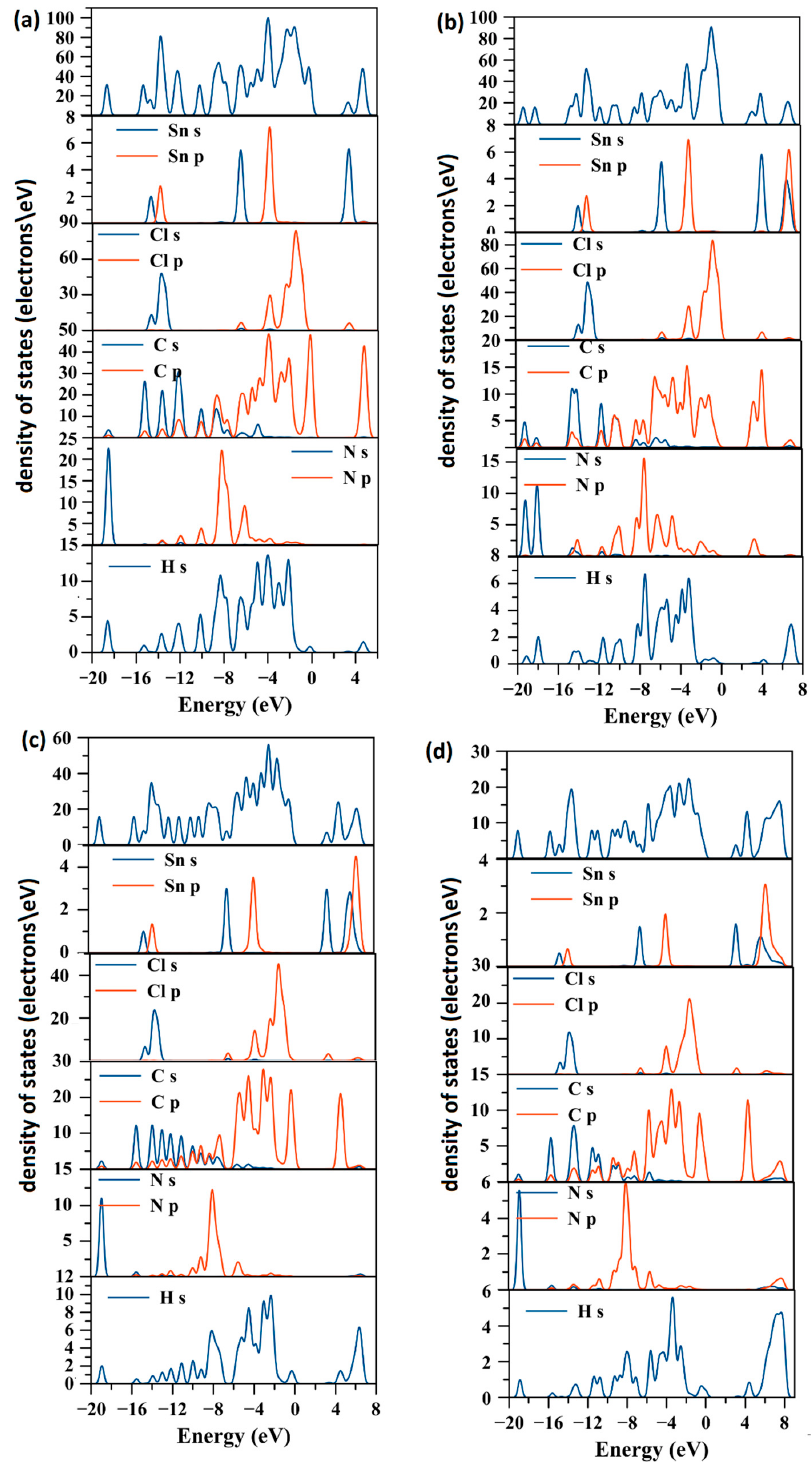
Figure 4. Total and partial density of states of different studied tin (IV) hybrid organic–inorganic materials: ( a ) (NH 3 (CH 2 ) 2 C 6 H 5 ) 2 [SnCl 6 ], ( b ) (C 6 H 10 N 2 )[SnCl 6 ], ( c ) (C 9 H 14 N) 2 [SnCl 6 ], and ( d ) (C 8 H 12 N) 2 [SnCl 6 ].